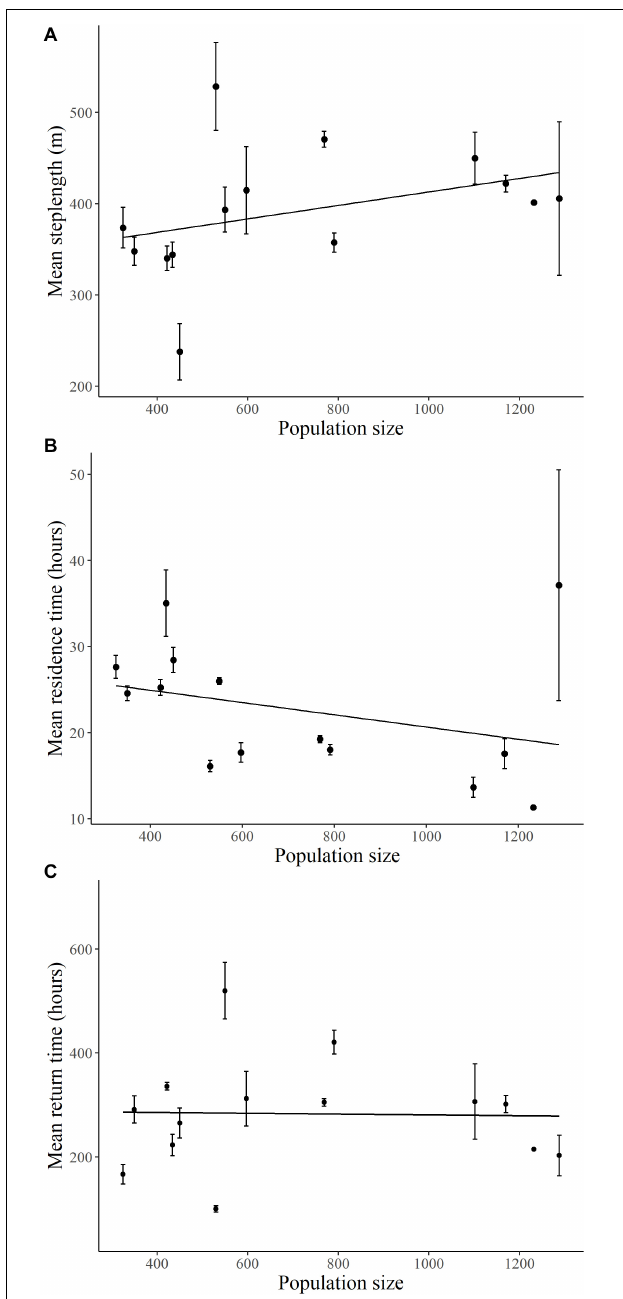
FIGURE 4 | Relationships between elk population size on the Ya Ha Tinda winter range adjacent to Banff National Park, Alberta, Canada, during winters from 2002–2003 to 2015–2016 and (A) diurnal step lengths (2-h), (B) residence times (within 800 m), and (C) return times (200 m, 48 h) of GPS-collared elk. Error bars show +1 standard error. Lines are best-fit models for migrant (solid circle/line) and resident (open circle/dotted line) elk. Supplementary Table S4 provides model